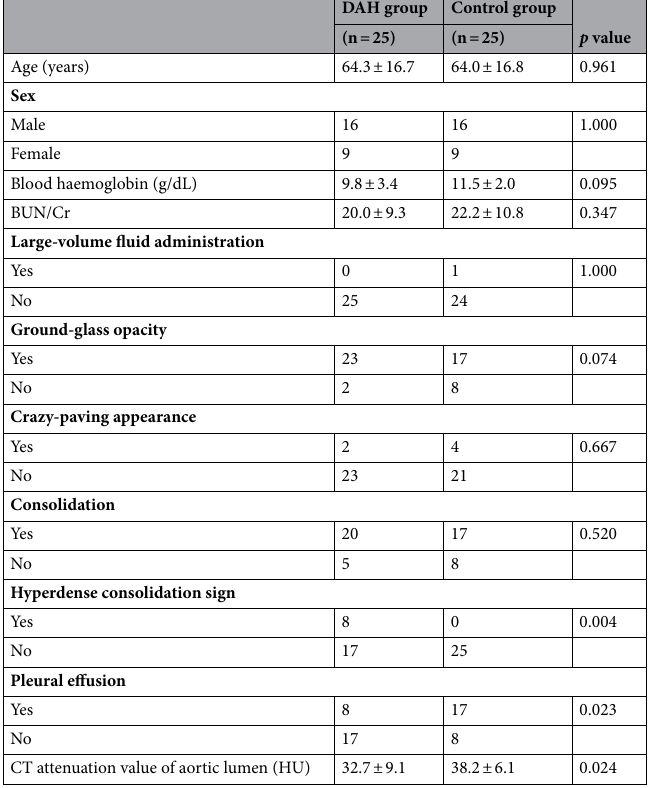
Table 3. Patient characteristics, laboratory data, and CT imaging data. Values are given as n or the mean ± SD. DAH, diffuse alveolar hemorrhage; BUN, blood urea nitrogen; Cr, creatinine; CT, computed tomography, HU, Hounsfield